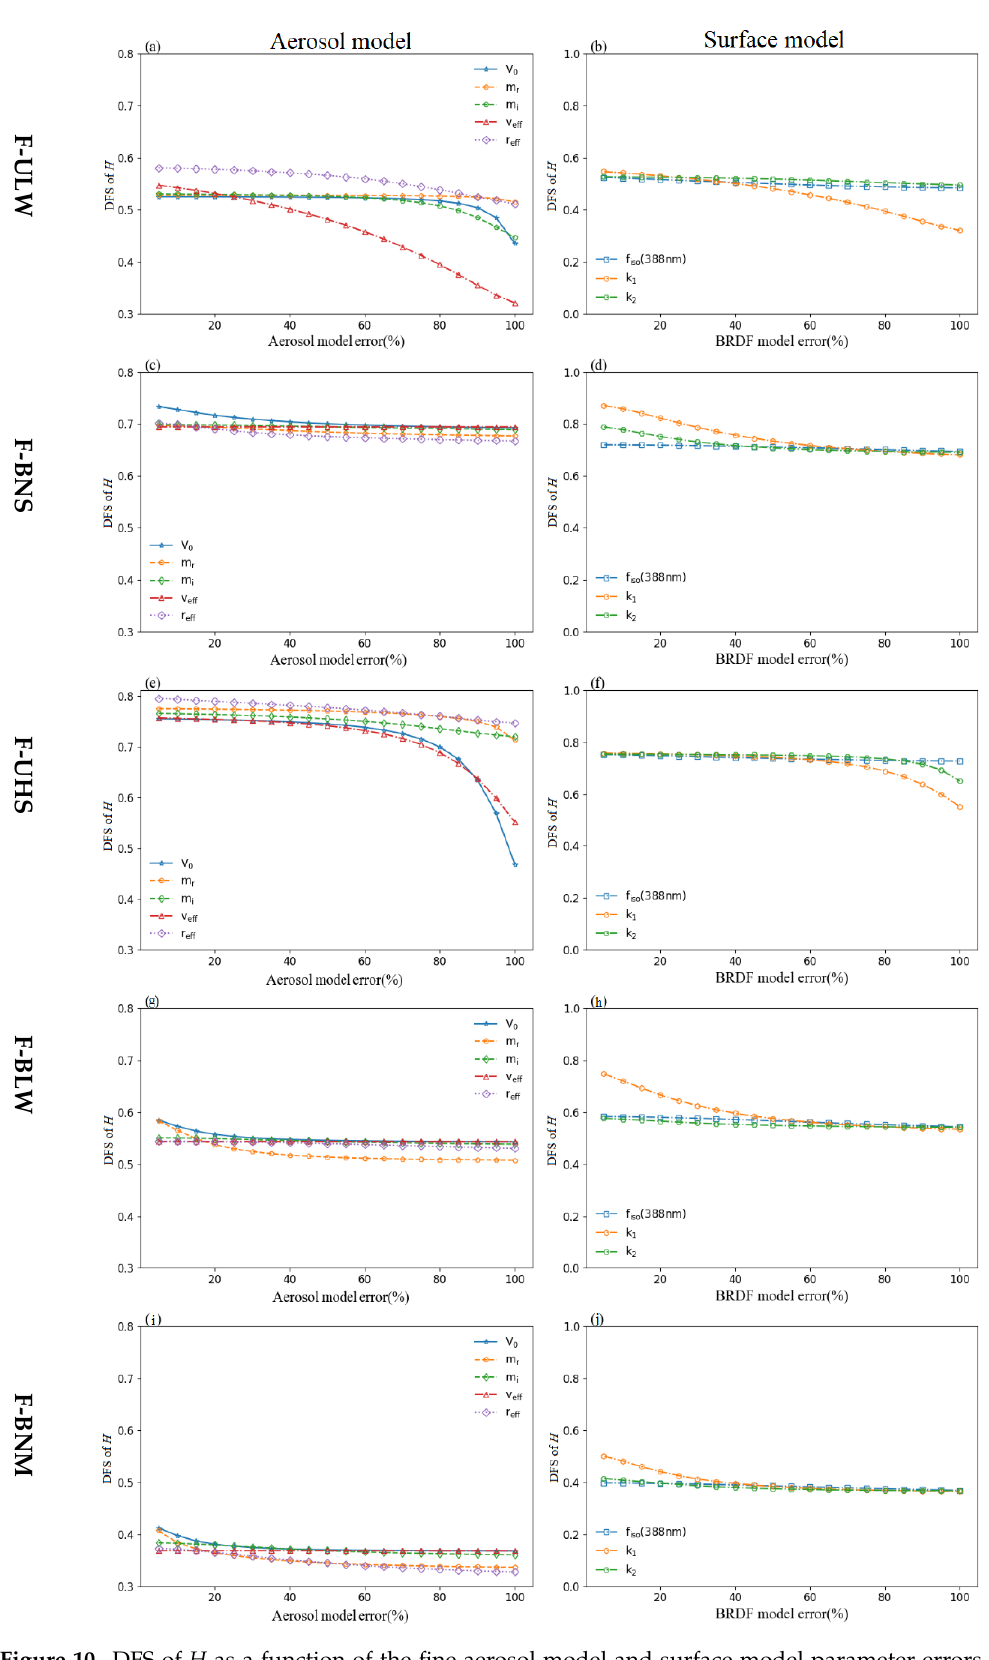
Figure 10. DFS of H as a function of the fine aerosol model and surface model parameter errors from 5% to 100% in steps of 5% with AOD = 0.6, in which left ( a , c , e , g , i ) and right panel ( b , d , f , h , j ) corresponds to the aerosol model and surface model respectively.